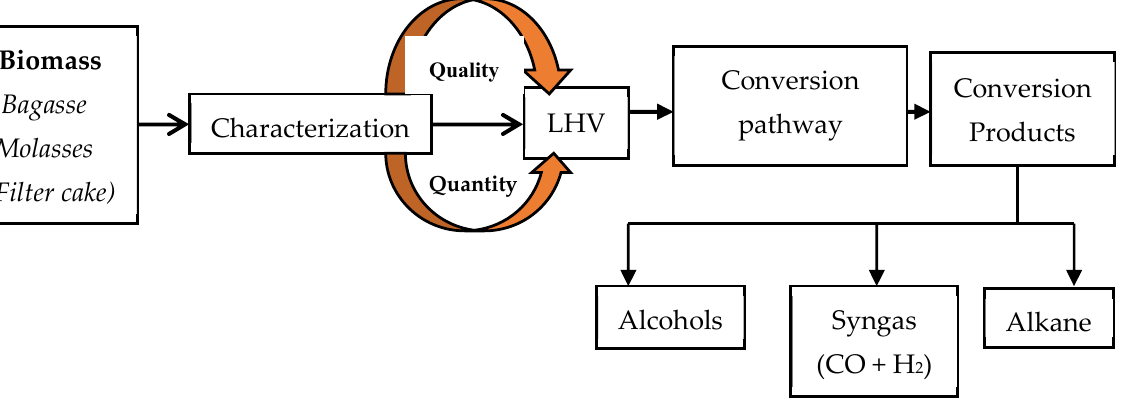
Figure 1. Conceptual block diagram biomass to bio-fuel conversion scheme.